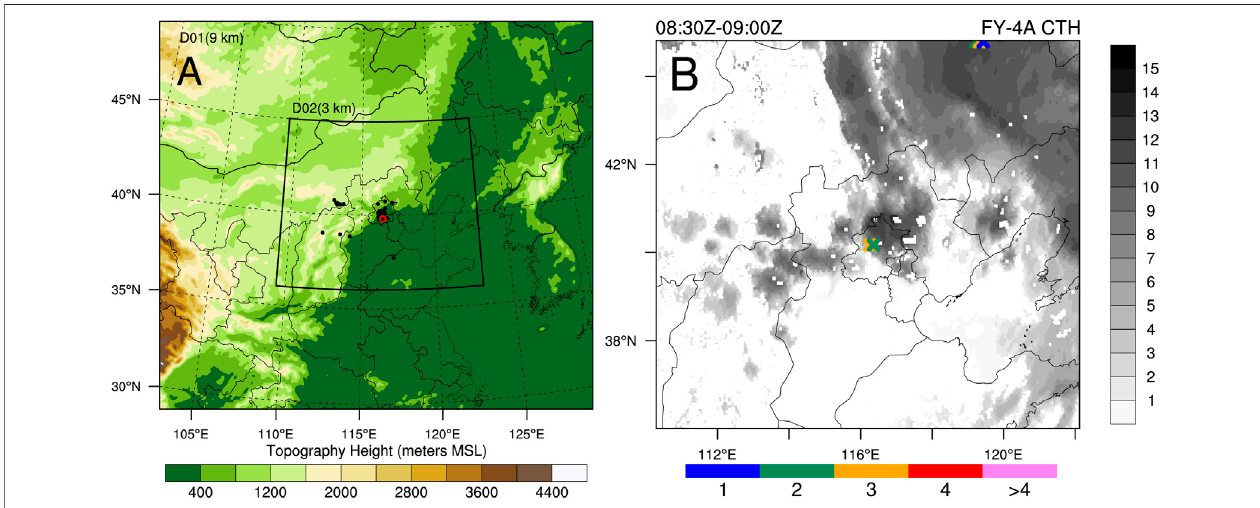
FIGURE3|(A) Con fi gurationofthetwonestedweatherresearchandforecasting(WRF)simulationdomainsinLambertconformalprojection,andtheterrainheight (shaded colors, unit: m). (B) The accumulated lightning frequency (colored cross signs) from 0,830 to 0900 UTC 9 August and the height of cloud top (gray shaded colors, unit: km). The black and red dots in panel (A) represent in-situ observed surface and sounding stations.